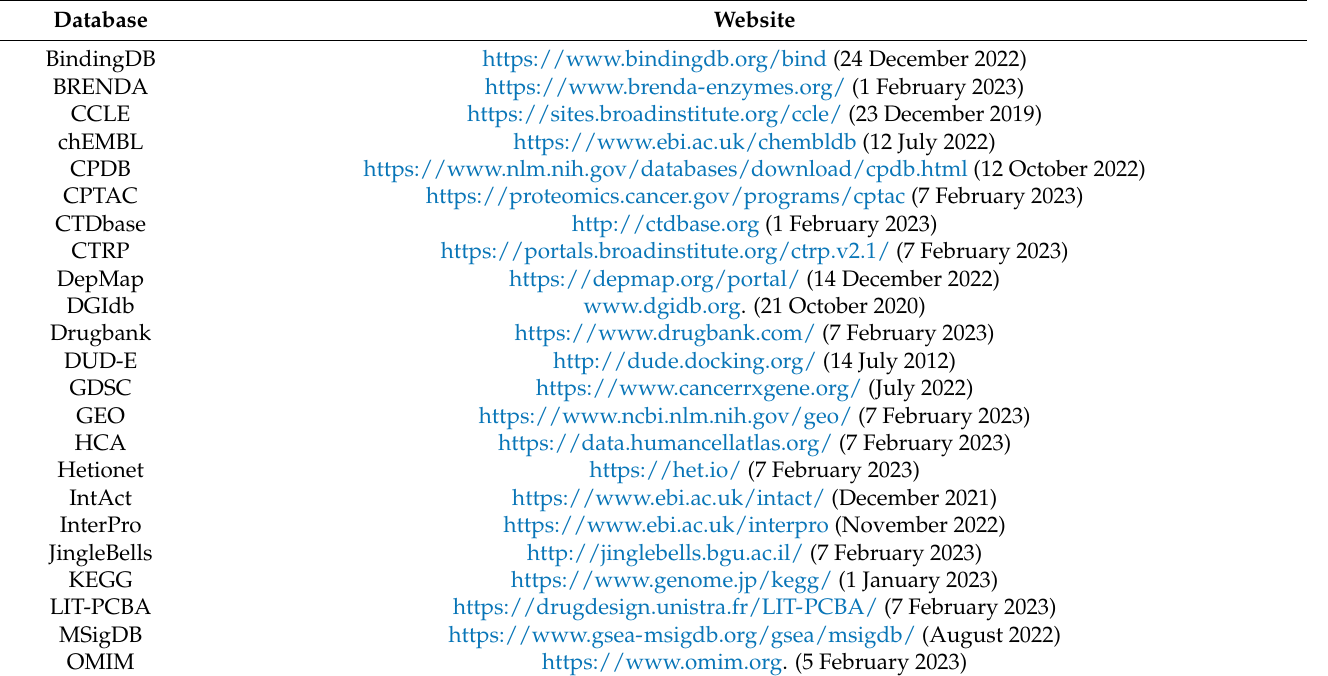
Table 7. Different data sources for anti-cancer drug